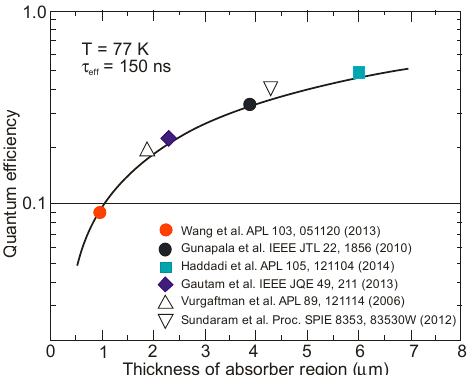
Figure 55. QE versus thickness of active region for InAs / InAs 1 − x Sb x T2SL photodetectors at 77 K. The theoretical prediction (solid line) is compared with the experimental QE reported by different research groups as indicated inside the figure (adapted after [169]).